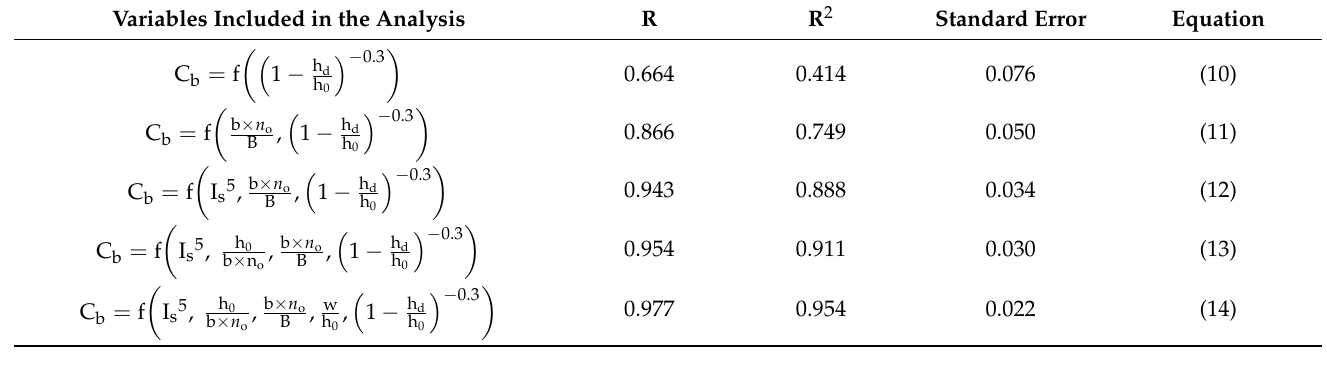
Table 3. Successive regression analysis of the averaged discharge coefficient C b ; variables included in the analysis; multiple correlation coefficient R, multiple determination coefficient R 2 , and the standard error.